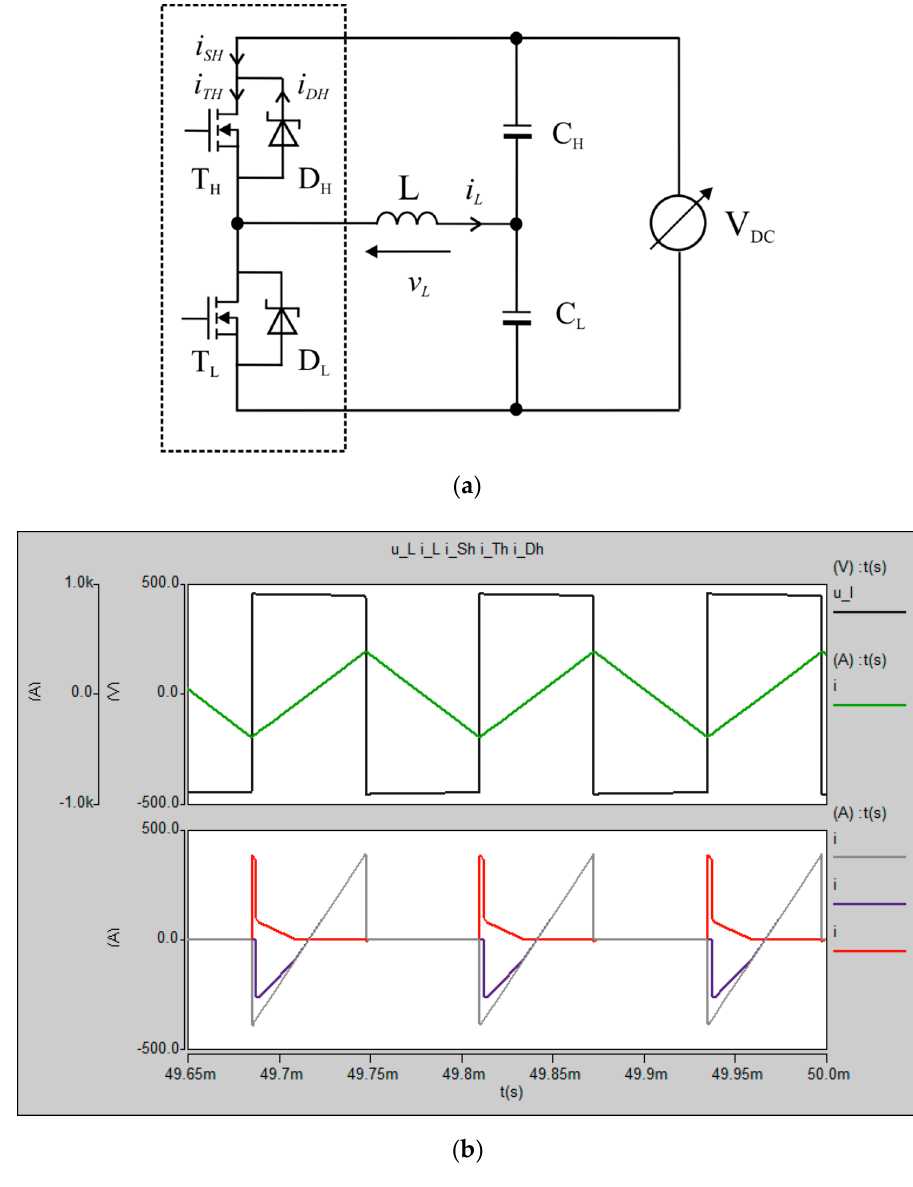
Figure 4. Half-bridge circuit ( a ) and basic waveforms ( b ) for square-wave operation simulated in Saber.